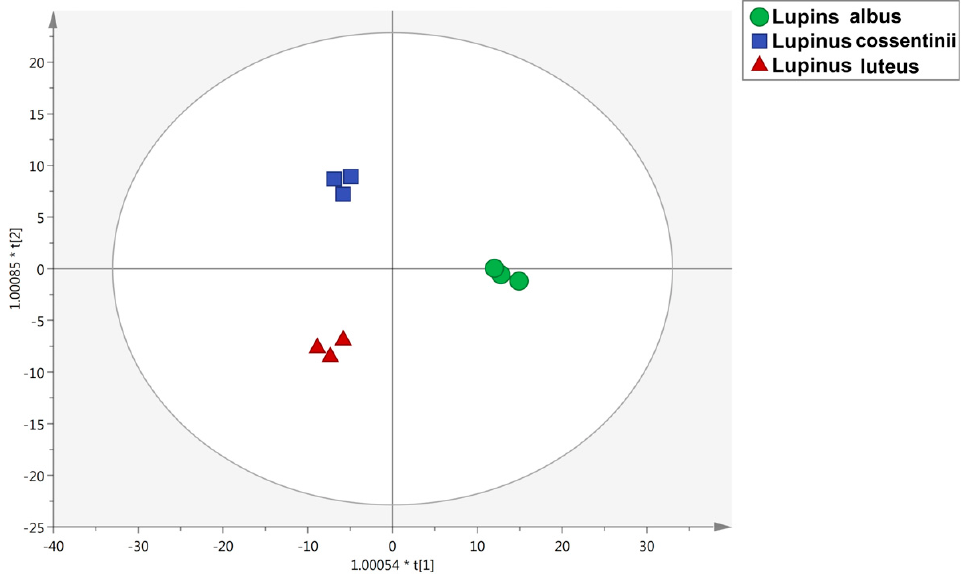
Figure 2. Orthogonal projection to latent structures discriminant analysis (OPLS-DA) built consider- ing the phytochemical profile (from UHPLC-QTOF) of different seeds of the three Lupinus species. The phenolic markers with a VIP score > 1 belonged mainly to flavonoids 36.1%, includ- ing anthocyanins (cyanidin 3- O -xylosyl-rutinoside; cyanidin 3- O -glucosyl-rutinoside; cyani- din 3- O -sambubiosyl 5- O -glucoside; pelargonidin 3- O -(6”-succinyl-glucoside)), flavones (apigenin 6- C -glucoside; apigenin 7- O -glucoside) and flavonols (these were kaempferol 3- O -rhamnoside; quercetin 3- O -glucosyl-xyloside; quercetin 4’- O -glucoside). The